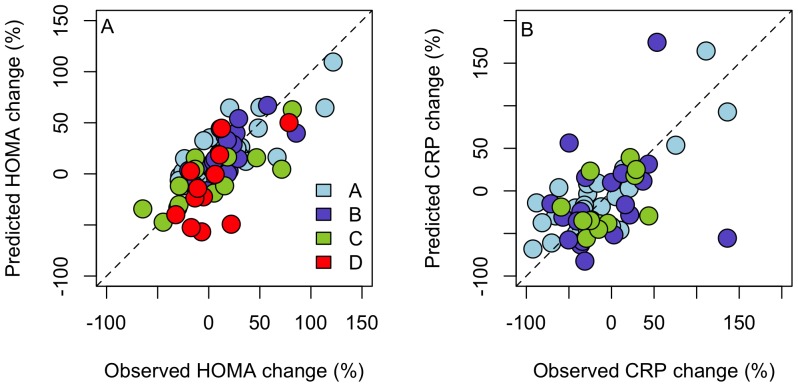
Validation of the HOMA (panel A) and CRP (panel B) response models.In each case, one study was left out, while data from the other studies were fitted to the model, which was then used to predict the HOMA and CRP response for the independent data set (A–D). The dashed line represents the ideal situation where observed  =  predicted.